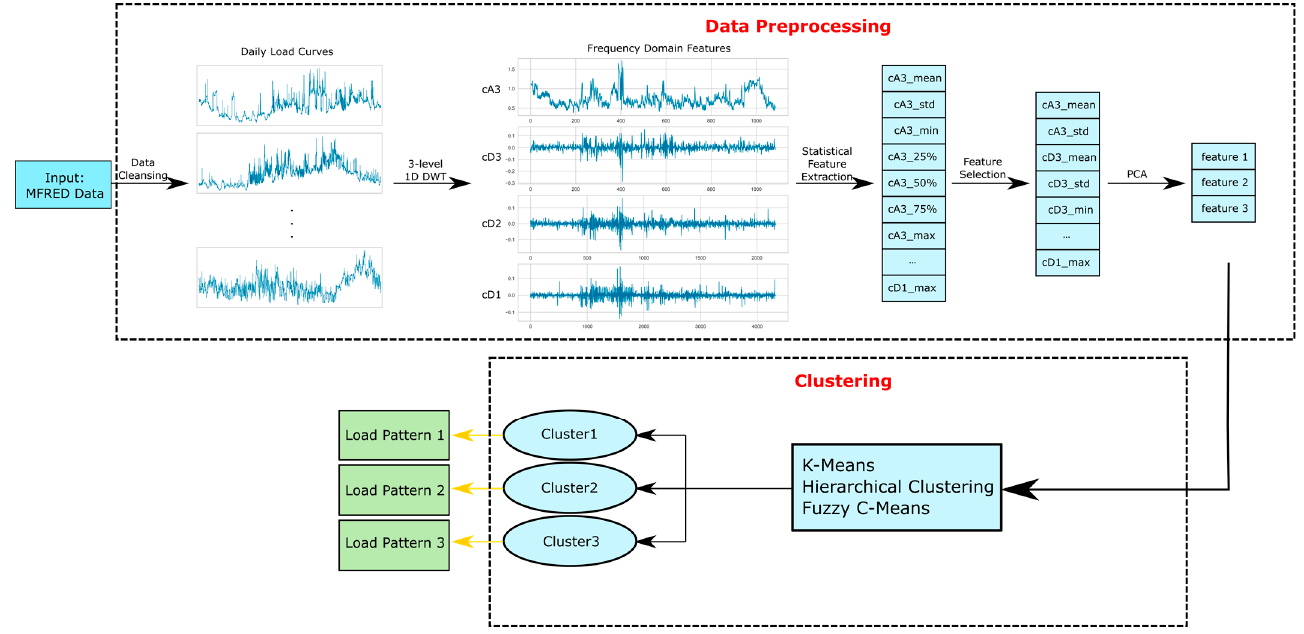
Figure 2. The proposed system diagram for electricity pattern analysis by clustering domestic load profiles.